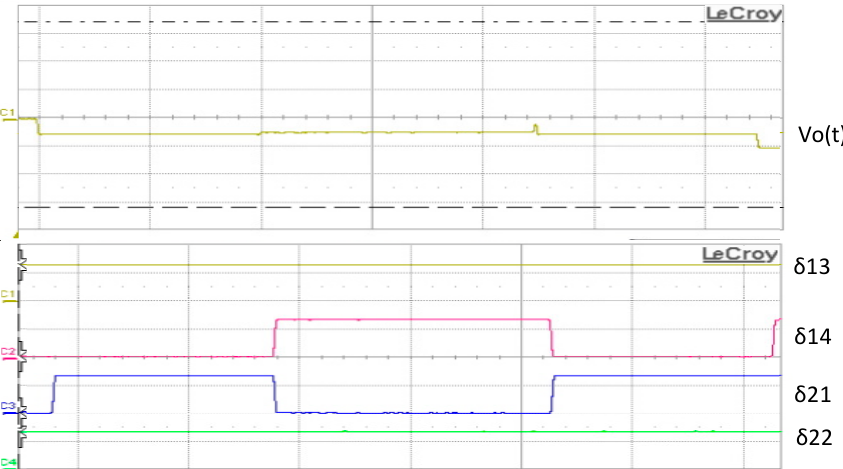
Figure 22. Output voltage V o (t) and switching patterns sent to T11, T12, T23, and T24 (ZOOM 2 in Figure 20).